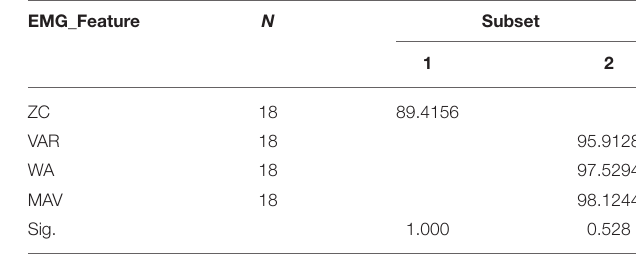
TABLE 16 | The results of the Tukey HSD for ρ